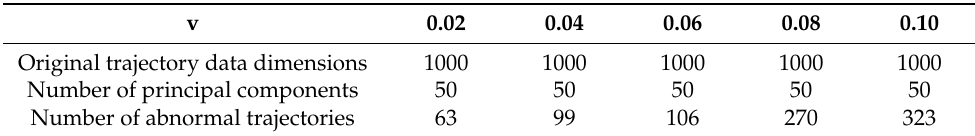
Table 3. Experimental result of parameter v (p = 0.9, ω = 8). v